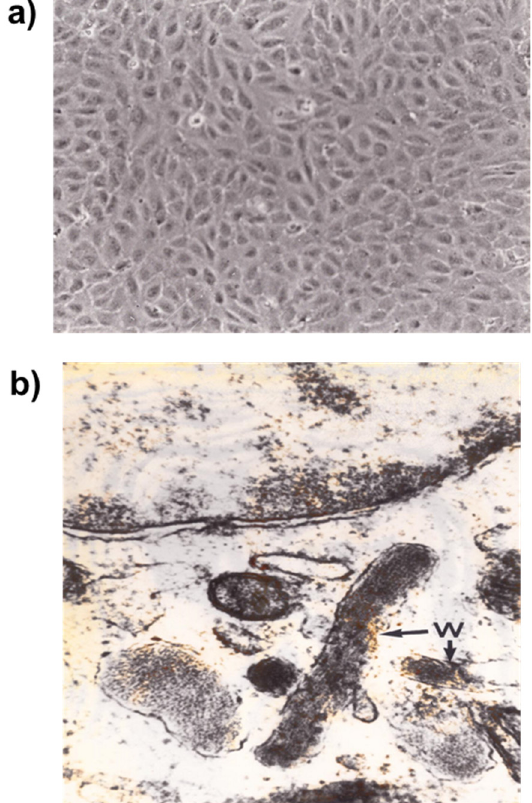
Figure 1. Cultured Human endothelial cells. Human Umbilical Vein Endothelial Cells (HUVEC) were cultured in Petri dishes until confluence and observed using an inverted microscope (×70) ( a ). In the ultrastructure the Weibel-Palade bodies (W) (electron microscope, ×50,000) used as a hallmark of endothelial cells, are secretory organelles used for post-synthesis storage in endothelial cells ( b ).